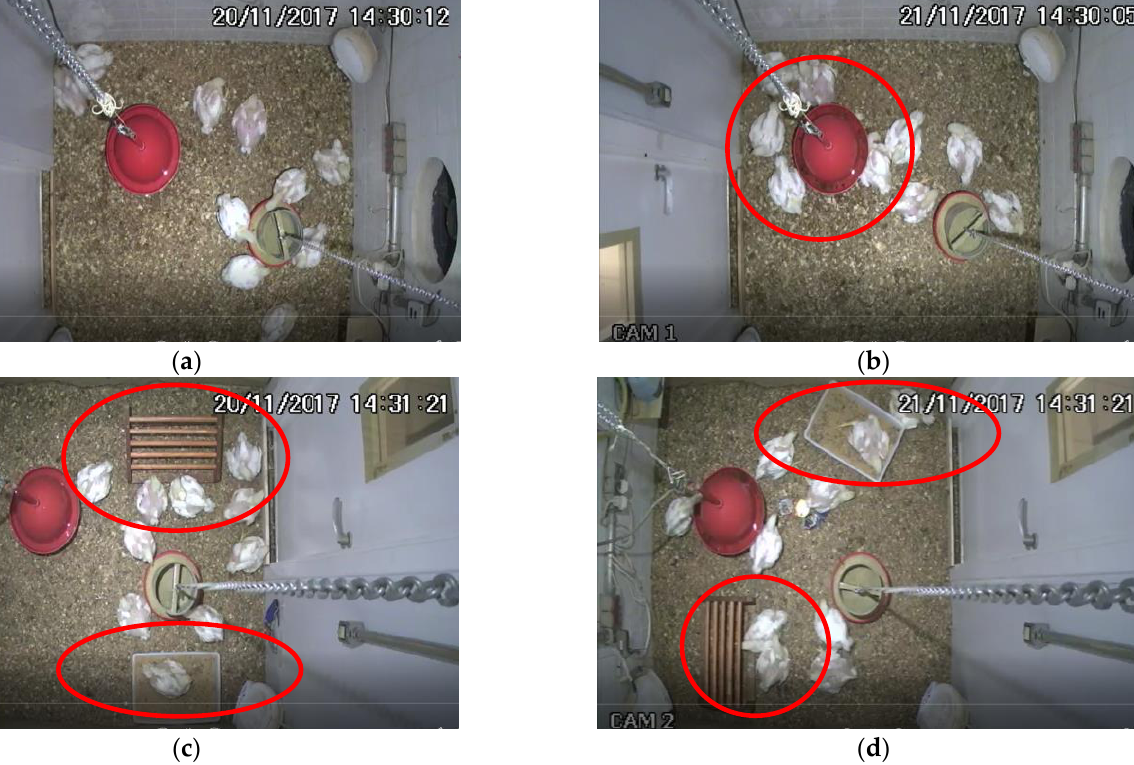
Figure 7. Frames evaluated are ( a ) nonenriched environment in comfort, ( b ) nonenriched environ- ment under heat stress, ( c ) environment enriched in comfort, and ( d ) enriched environment under heat stress.